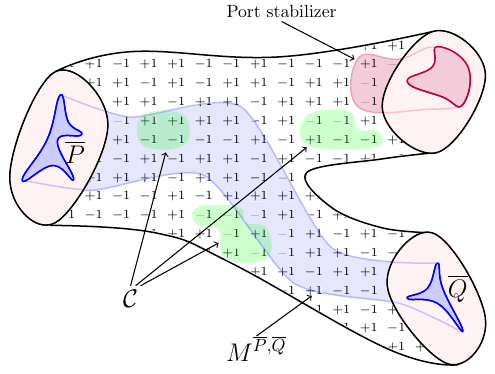
FIG. 2. Abstract schematic of a fault-tolerant instrument with one input port (left) and two output ports (right) (all shaded in pink). In the stabilizer framework, outcomes correspond to measurement of Pauli product observables and checks take the form of joint parity constraints. The + 1 and − 1 represent the physical measurement outcomes in O . While each measurement outcome may individually be random, checks identify subsets of outcomes (depicted here in green) for which the joint parity is fixed (in the absence of errors). Example of a logical correlator P ⊗ Q ∈ S ( U ) represented by a logical membrane M P , Q . A logi- cal correlator P ⊗ Q ∈ S ( U ) means that an input logical operator P is mapped to an output logical operator Q up to a sign depend- ing on outcomes of measurements supported on a representative logical membrane M P , Q . Here, S ( U ) denotes the stabilizer group of the stabilizer channel U . A concrete choice of such an instru- ment could be an encoding isometry for a 2-repetition code, mapping arbitrary states in the input space onto the subspace of the output space stabilized by Z ⊗ Z . The stabilizer generators ⊗ Z ⊗ for this instrument are given by S = (cid:2) Z in out 1 I out 2 , X in 1 1 ⊗ Z (cid:3) (where the tensor product is only , I in X out X out out 1 Z out 2 1 2 1 included to denote the input and output subsystems). For this choice, both P and Q correspond to the logical Z operators of their corresponding port codes (see Appendix A 1 for more